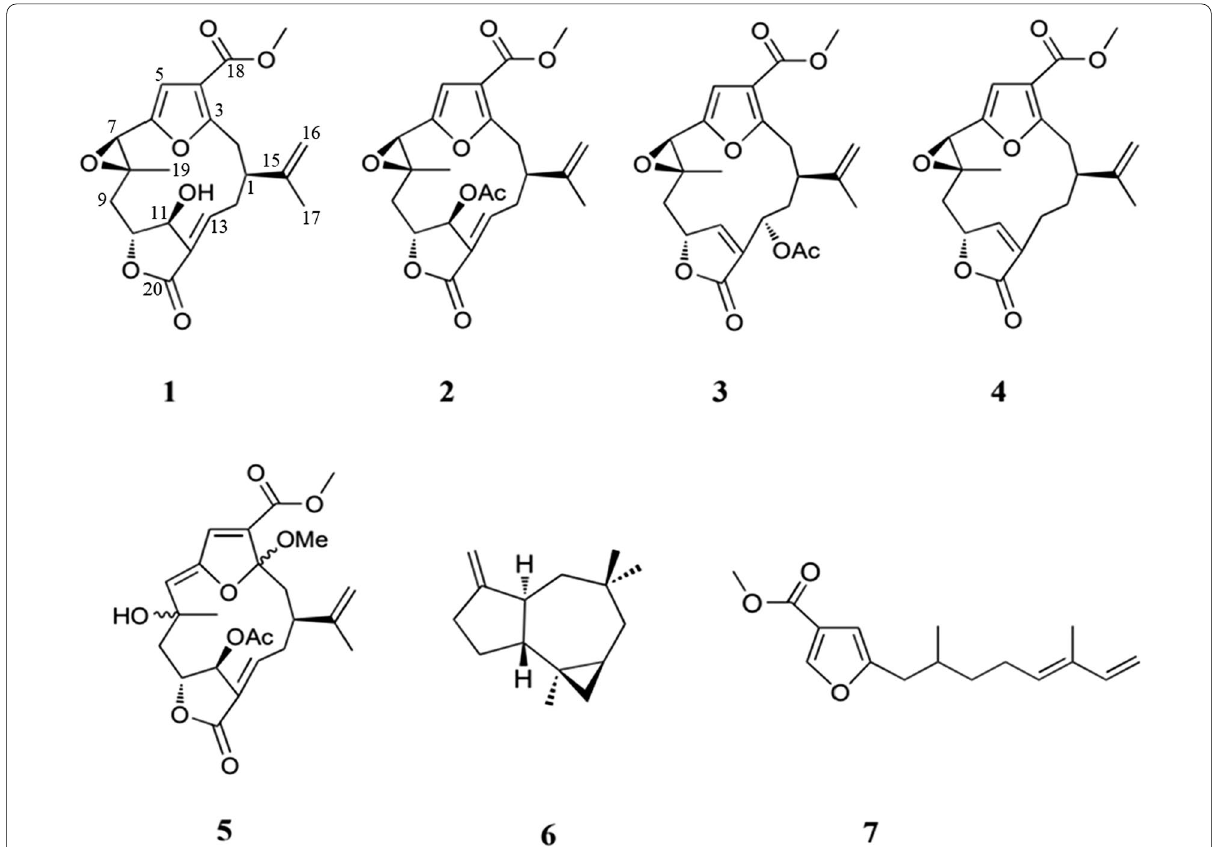
Fig. 1 Chemical structures of compounds